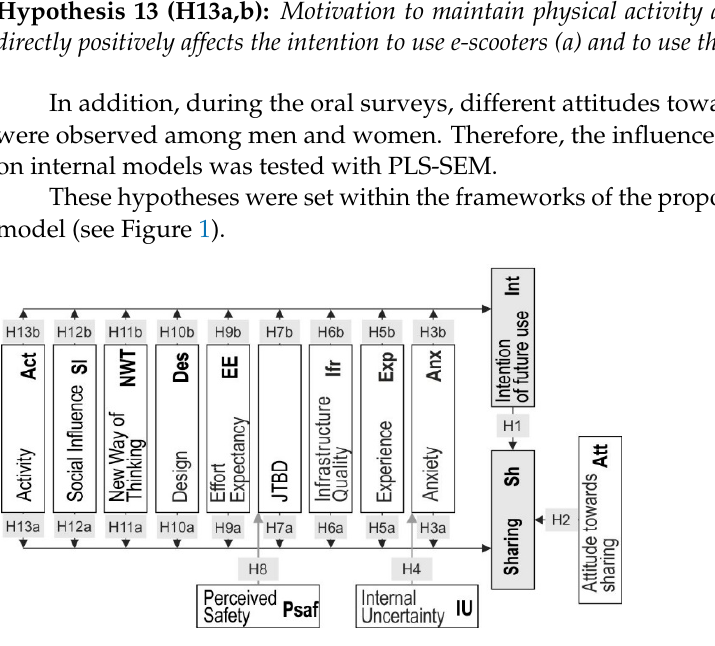
Figure 1. The proposed conceptual model of the research. (Source: figure was generated by the au-